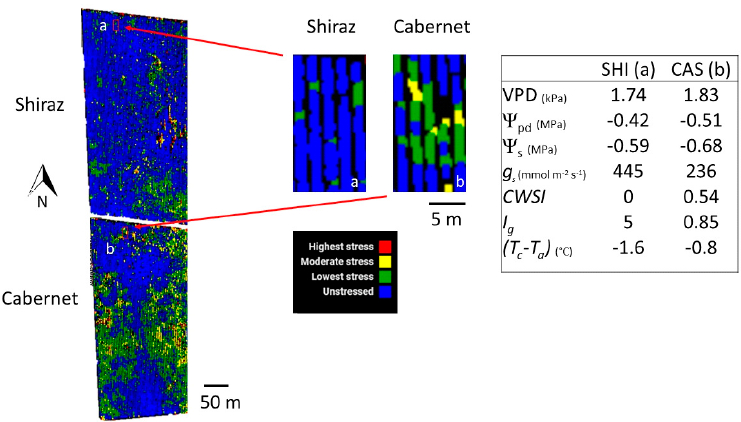
Figure 2. Comparison of vine water status between cultivars SHI ( a ) and CAS ( b ) using remotely-sensed thermal images colour-coded to temperature. Colour codes of relative values: Blue / green = low / no water stress, yellow / red = moderate water stress. Data presented in the table above is for the position marked by red box / arrow head on the maps and indicates the proximity of the vines used for ground-truthing.